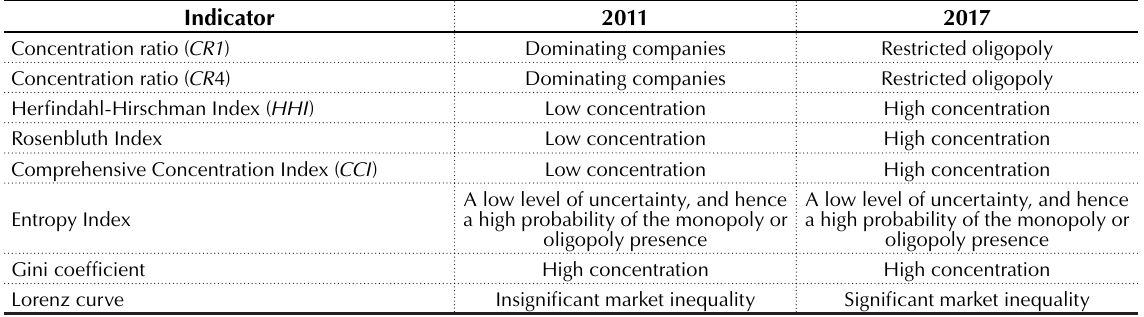
Table 7. General results of concentration indicators analysis for the Ukrainian stock market (cases